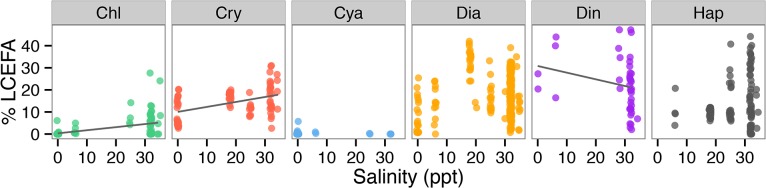
Phytoplankton group specific correlations between the Σ LCEFA in the % FA dataset and salinity of culture conditions.Salinity and % LCEFA was positively correlated (Kendall’s Tau, p<0.001) for chlorophytes and cryptophytes, negatively correlated for dinoflagellates, and not correlated for the other groups. Group abbreviations follow Fig 1. All points within each algal group are the same color, but are plotted with semi-transparency to accommodate for over plotting of points with similar values. Separate correlations for each phytoplankton group were performed due to the larger within-group sample sizes in this dataset.